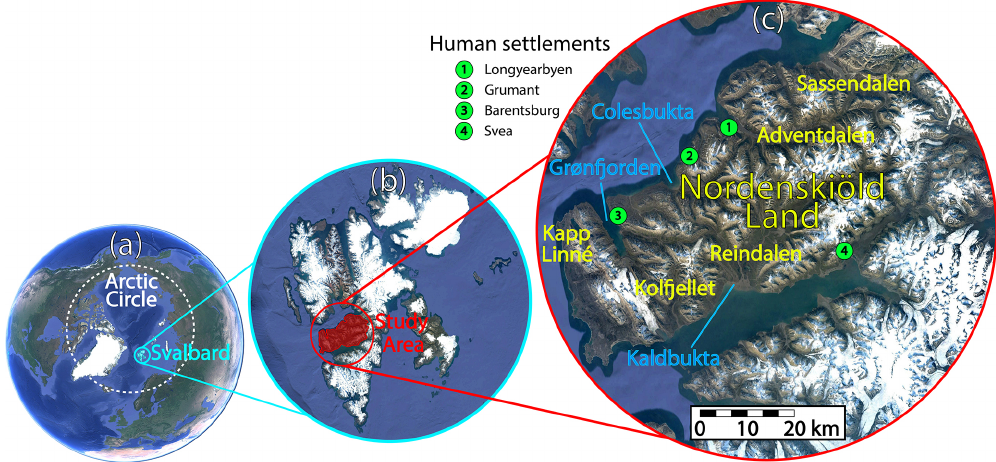
Figure 1. Panels showing location of the study area in the context of (a) the Northern Hemisphere, (b) the Svalbard Archipelago, and (c) local settlements, with colour-coded details where toponyms appear in yellow and fjords in blue (base maps from © Google